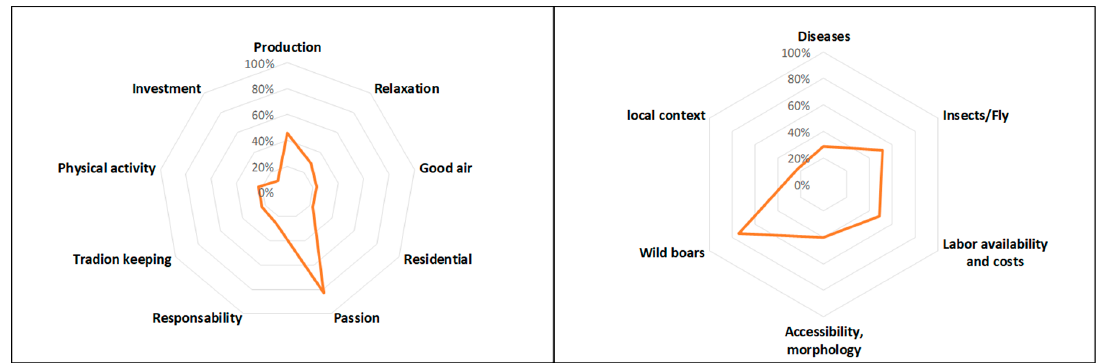
Figure 7. ( left ) Motivations for hobby farming in the surveyed sample ( n = 35). ( right ) Constraints for the olive grove hobby farmer samples ( n = 35); % refers to the total per item.